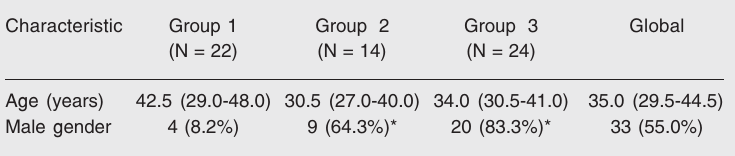
Table 1. Demographic characteristics of the patients studied.